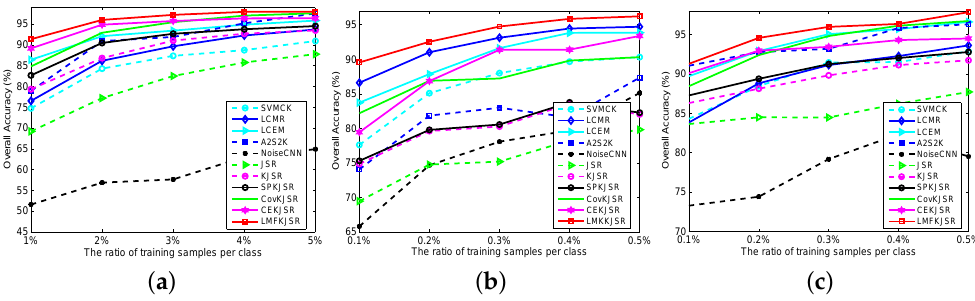
Figure 8. The OA versus the ratio of training samples per class: ( a ) IP; ( b ) UP; ( c ) SA.